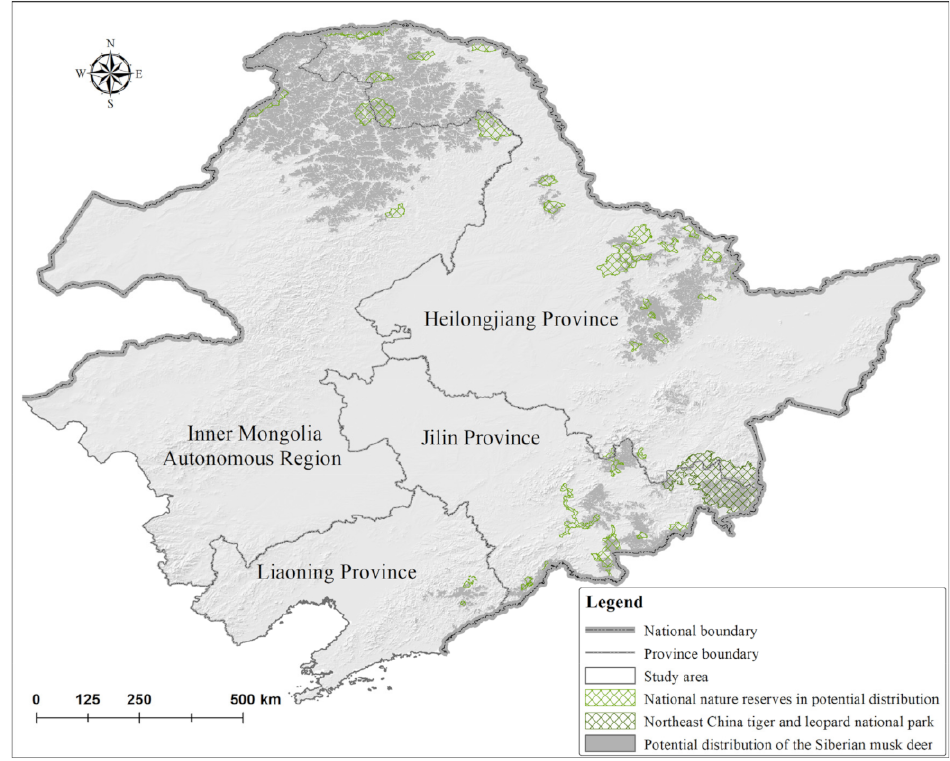
Figure 2. Potential distribution and conservation status of M. moschiferus (For basic information on protected areas, see Supplementary Materials: Table